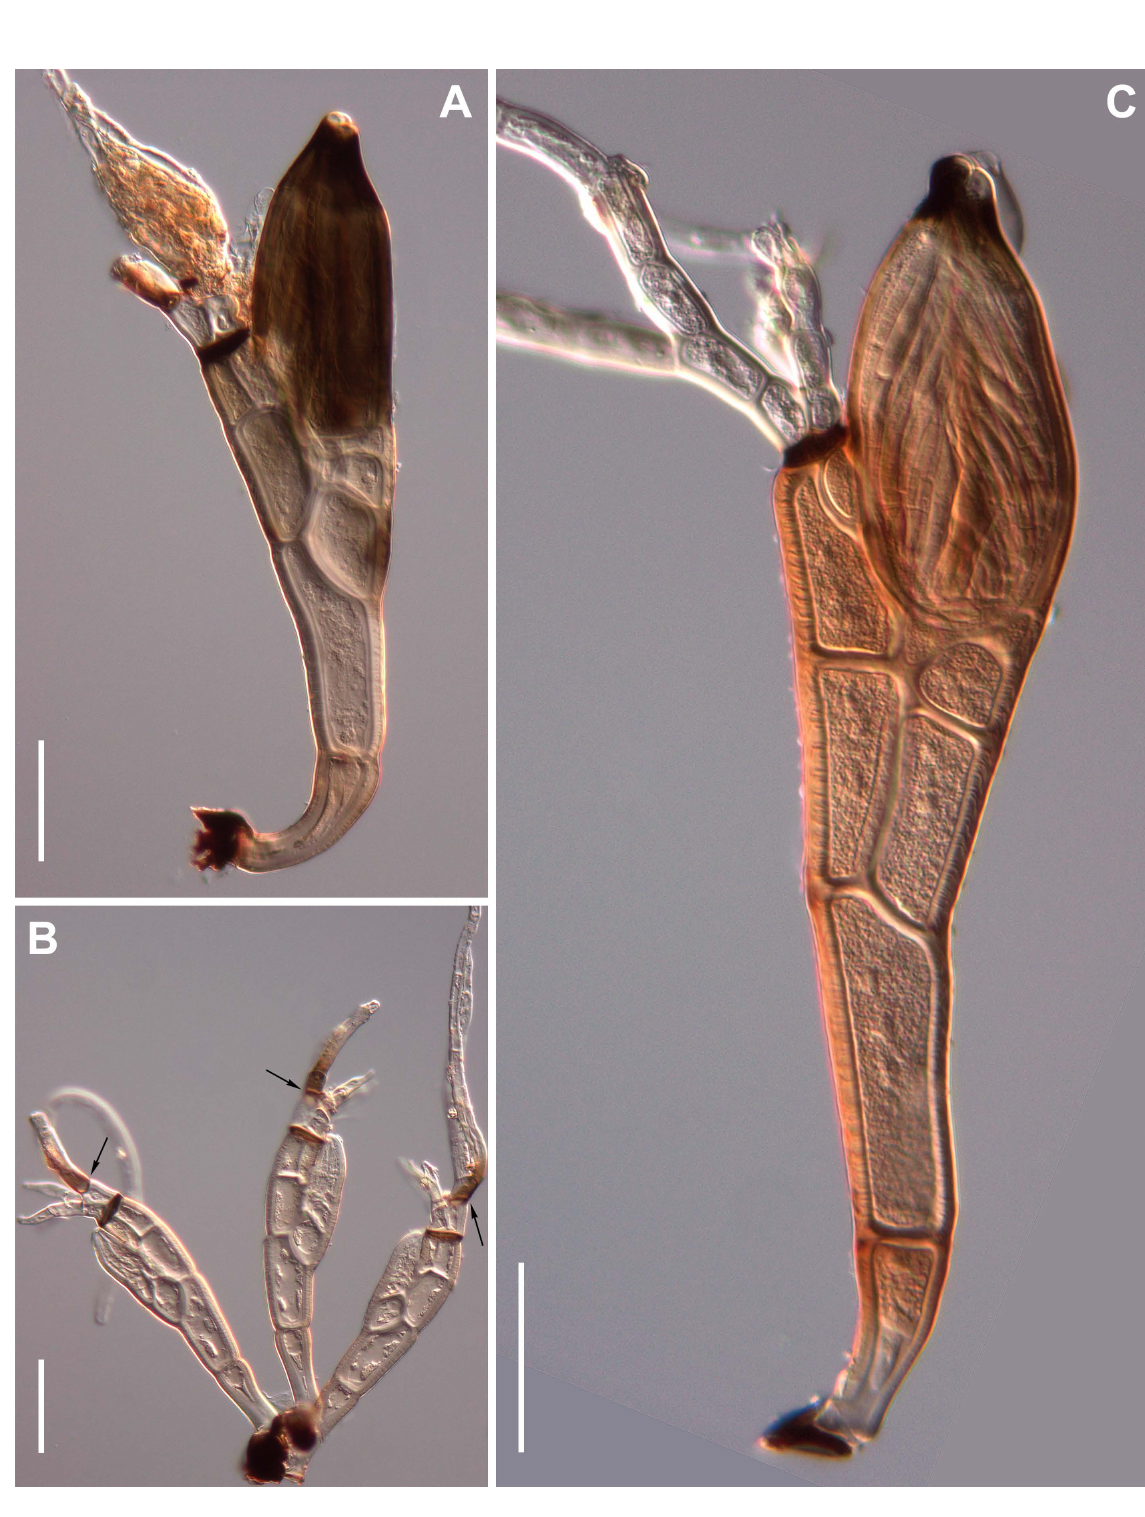
Fig. 27. Laboulbenia spp. A – B . L. clivinalis Thaxt. A . Mature thallus. B . Three immature thalli showing the oblique and blackened septum separating basal and suprabasal cells of outer appendage (arrows), a diagnostic character. – C . L. collae T.Majewski. Mature thallus. Scale bars: 50 µm. Photographs from slides ZMUC C-F-122501 (A–B), ZMUC C-F-123503